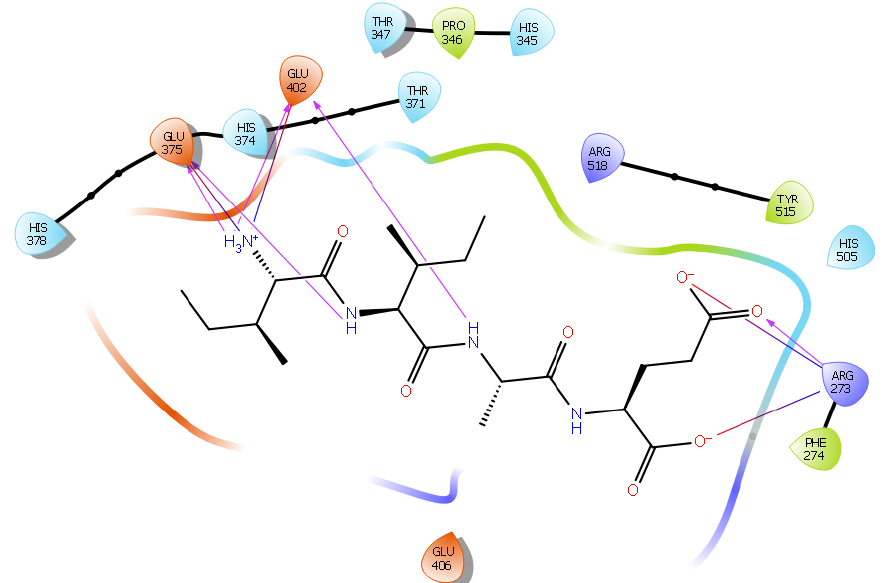
Figure 4. Docking results of the peptide IIAE in the active site of human ACE2. The interactions of human ACE2 residues with the peptide IIAE (represented in black) are indicated by arrows of different colors, with purple arrows representing hydrogen bond interactions and blue arrows representing salt bridge interactions.